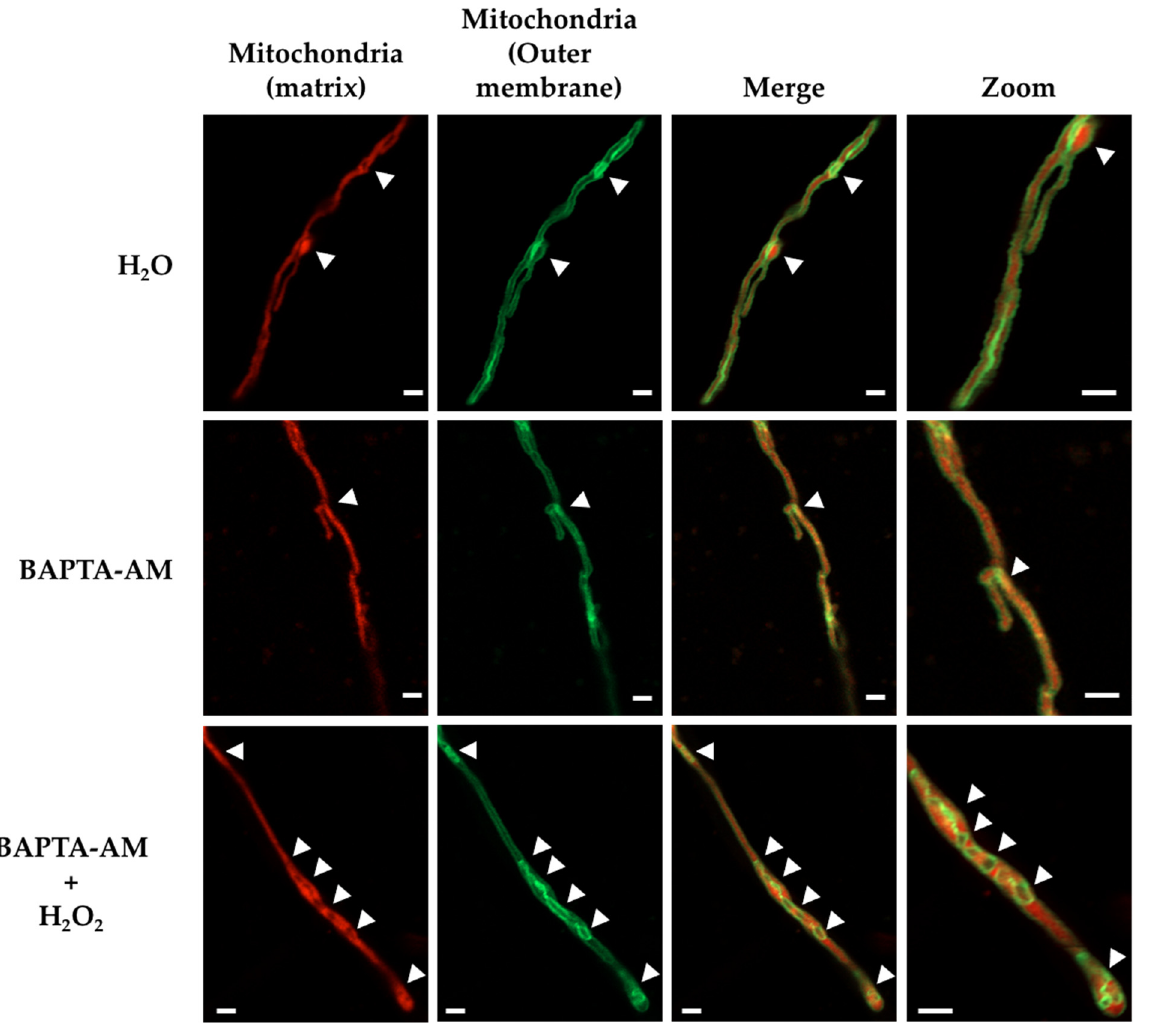
Figure 8. BAPTA-AM prevents mitochondrial constriction induced by H 2 O 2 but not the remodeling of the mitochondrial outer membrane. Mycelia from the Δ dnmA (CVG45) strain were grown for 18 h, incubated with 200 µM BAPTA-AM for 2 h, rinsed with sterile water, treated or not with 5 mM H 2 O 2 for 20 min, and then observed using Airyscan microscopy. The arrowheads indicate regions where the mitochondrial outer membrane is condensed or forms circular structures. Scale bar = 5 µm.